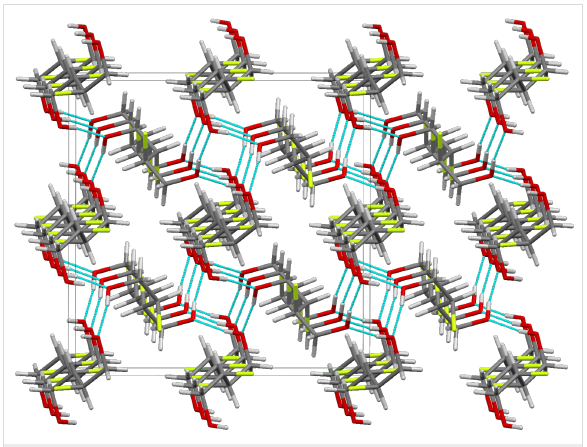
Figure 5: Crystal packing of 3 viewed along the c axis. H-bonds are shown in light blue.